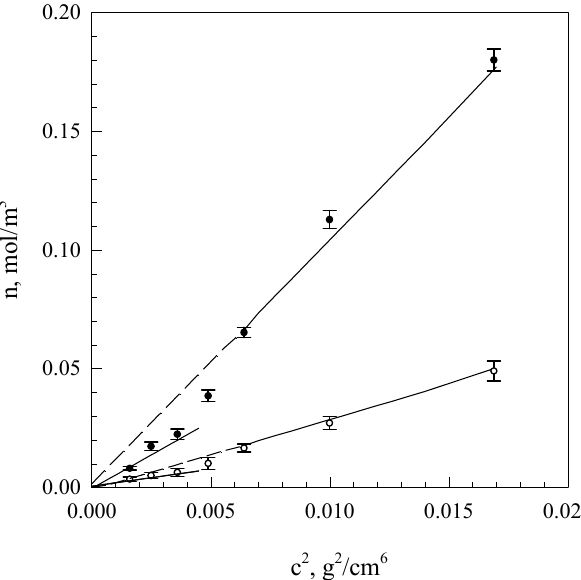
Figure 5. Interdependences of initial ( ◦ — n o ) and equilibrium ( • — n ∞ ) gel network segment concen- trations in the function of squared starch concentration in the system. The values are expressed as means ± SD ( n = 3).